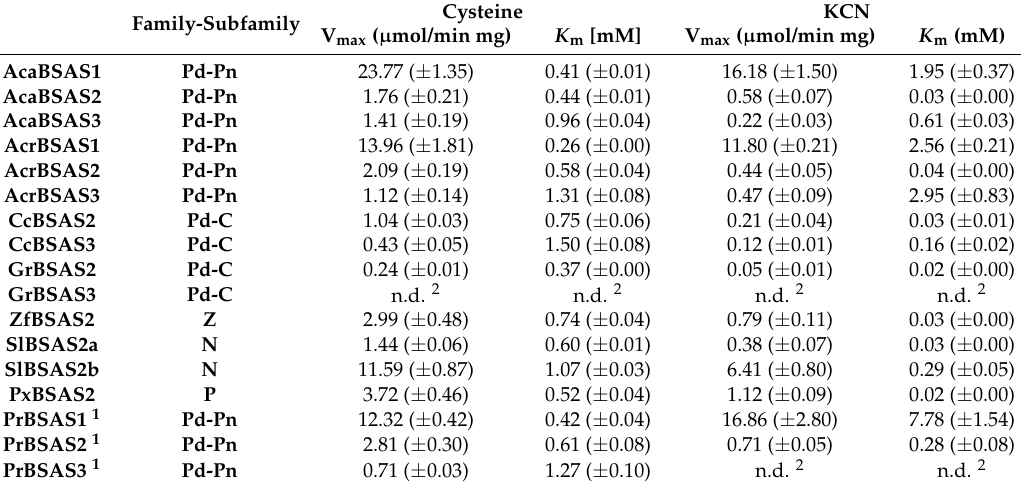
1 according to [13]; 2 n.d., not detectable (low protein